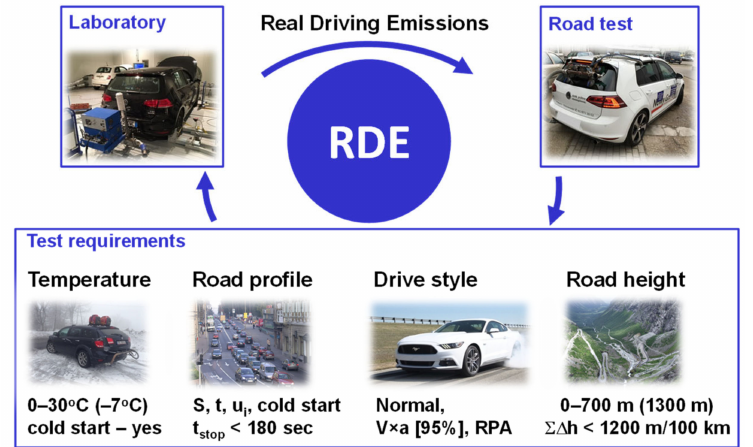
Figure 1. Formalized RDE test